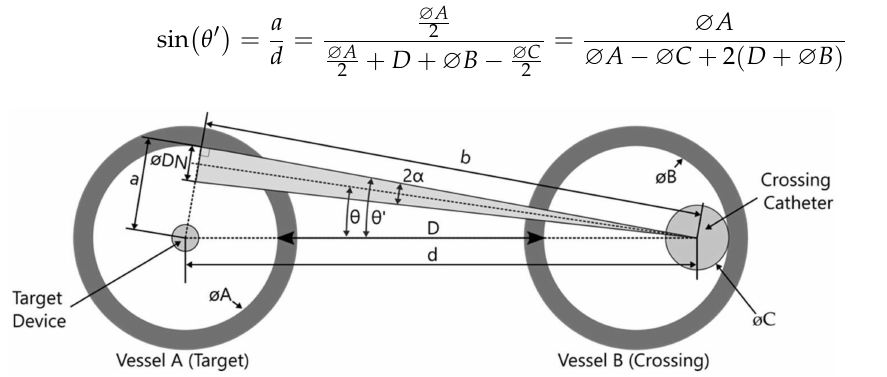
Figure 6. Geometric alignment error in vessel